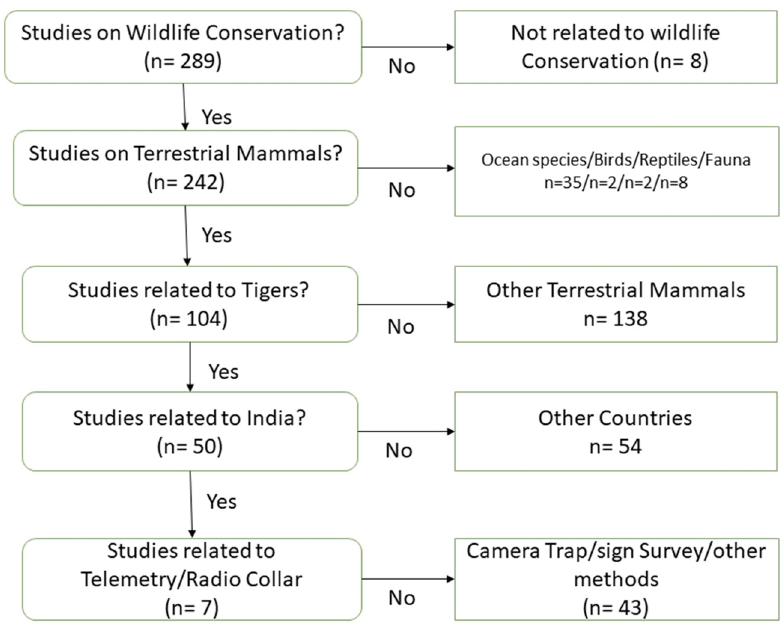
Figure 1: The fl owchart shows the process of fi ltering papers from database search for the review conducted in this study. Here n represents the number of papers for the respective block [ 52 ]